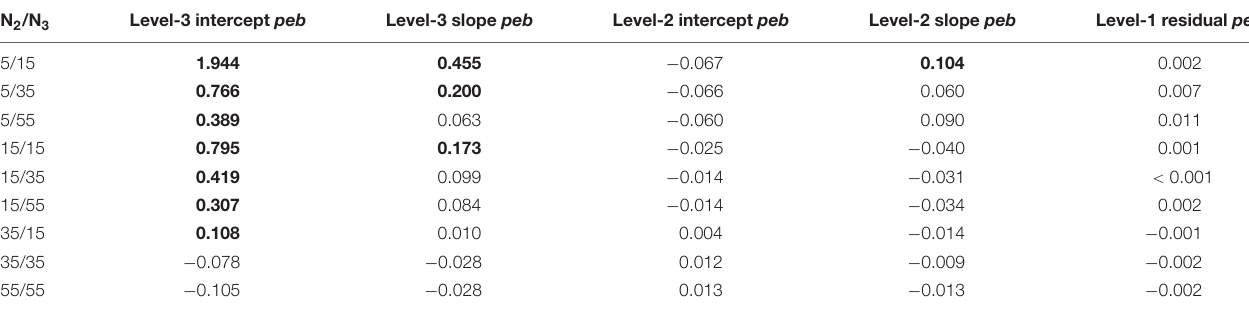
TABLE 12 | Parameter estimation bias (peb) of samples without missing values for variances of random effects. N 2 /N